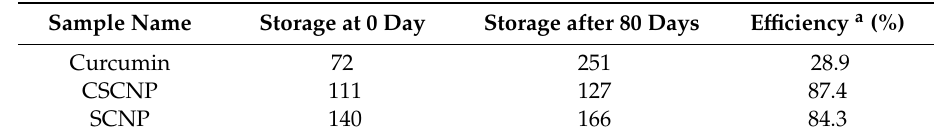
Table 3. Comparisons of the cell viability IC 50 of curcumin, SCNP, and CSCNP in Hep G2 cells while stored in water for 80 days ( μ g/mL).